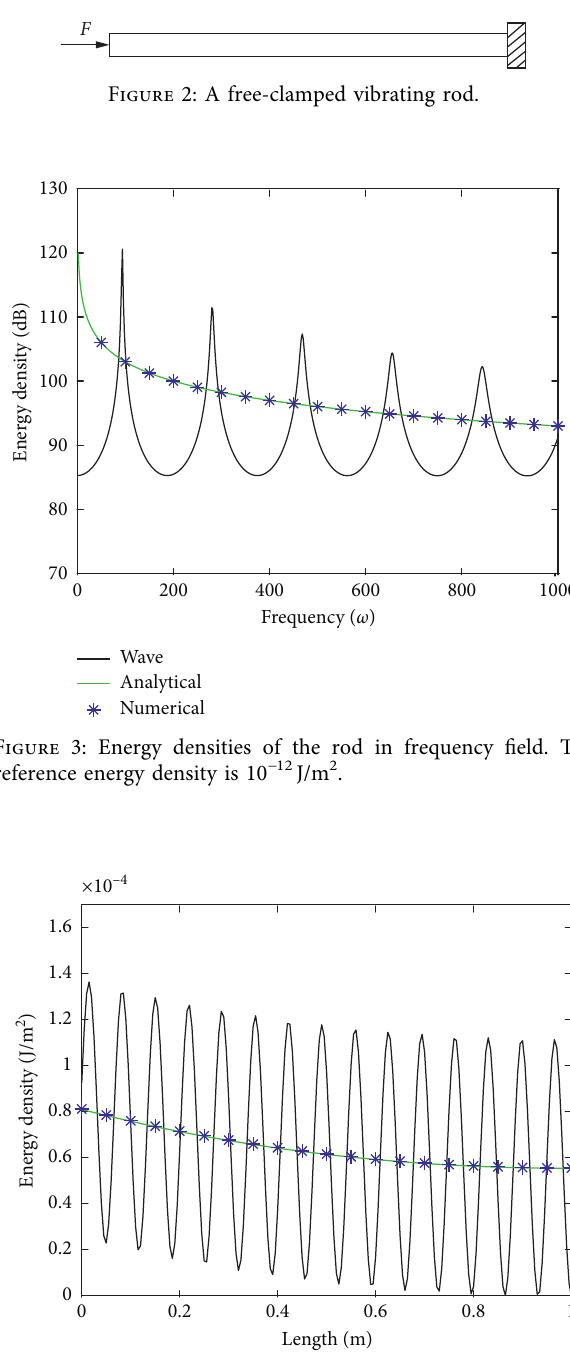
Figure 2: A free-clamped vibrating rod.